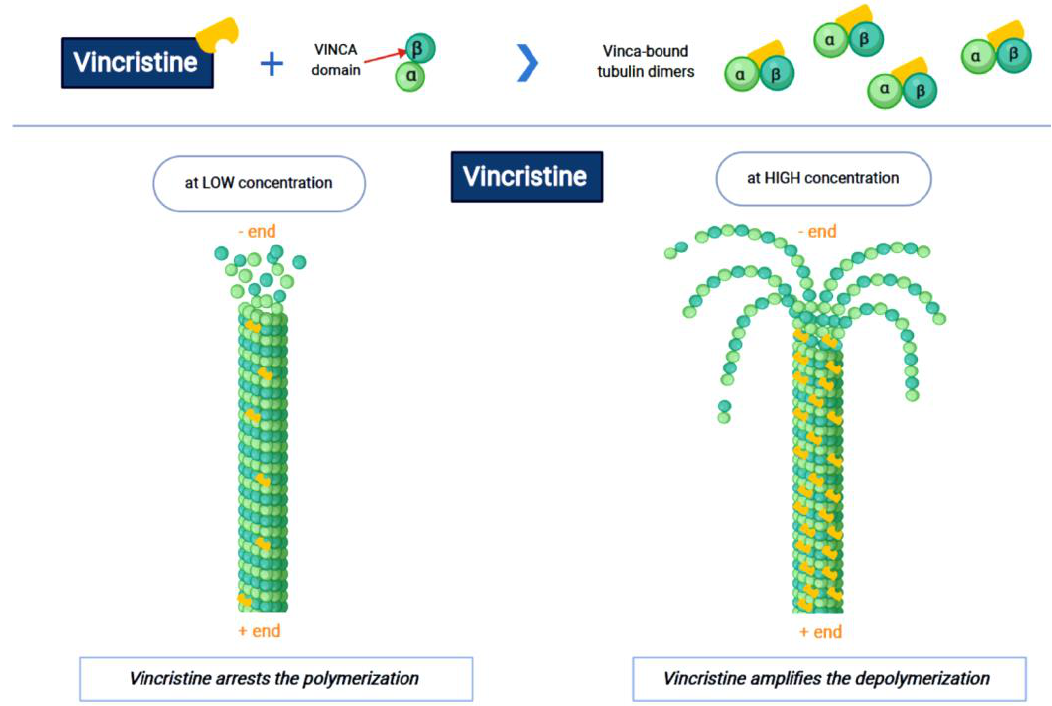
Figure 1. The first part of the figure shows the interaction between vincristine and the tubulin dimers. The second part shows the vincristine concentration-dependent action: the arrest of polymerization at low dose and amplification of depolymerization at a high dose.